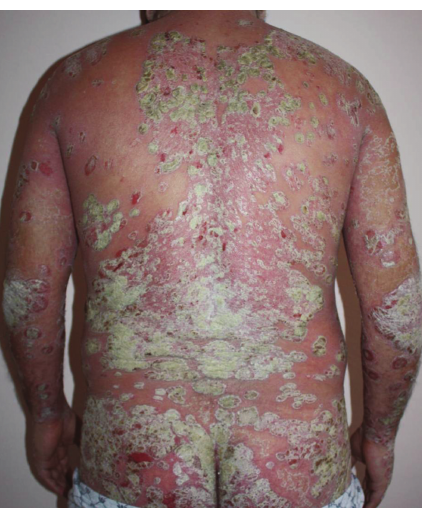
Figure 1: Severe plaque type psoriasis involving the face, scalp, trunk, and limps.